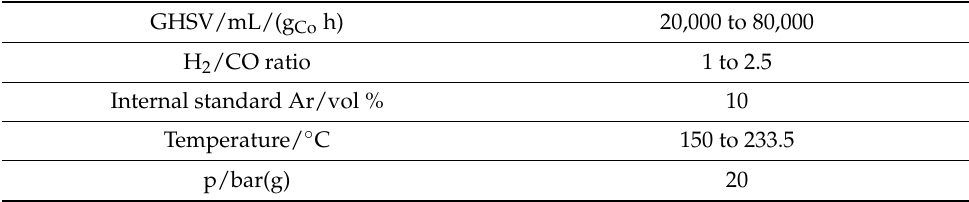
Table 4. Overview of experimental